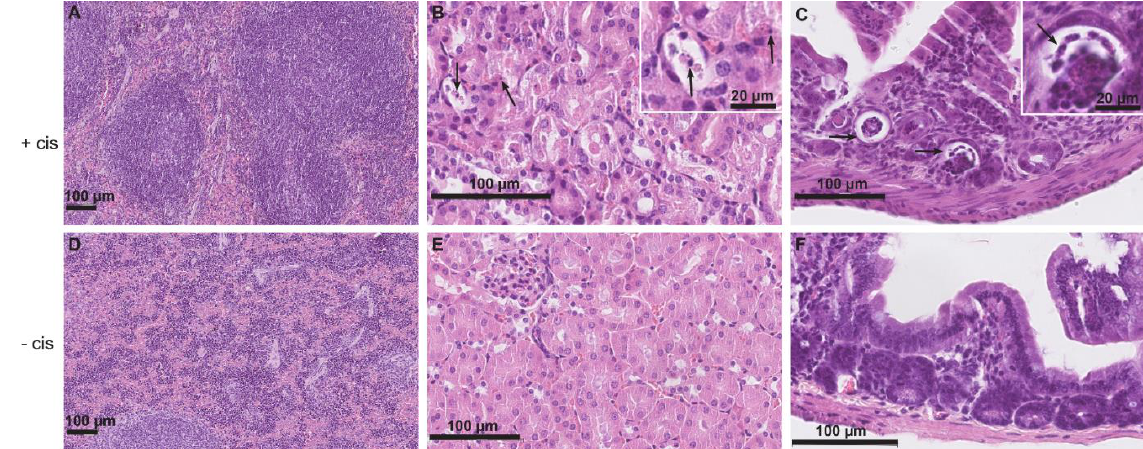
Figure 1. Representative micrographs of histopathologic changes of the spleen, kidney, and intestine in cisplatin-treated mice receiving MSCs labeled with NPs (+cis) ( A – C ) compared to control mice receiving MSCs labeled with NPs without cisplatin treatment ( − cis) ( D – F ). ( A ) In the spleen, cisplatin-induced widening of the red pulp and blurring of the boundaries between white and red pulp is evident. ( B ) In the renal cortex, numerous apoptotic tubular epithelial cells (arrows) are found. In the upper right corner is an insert with apoptotic epithelial cells at higher magnification. ( C ) In the intestine, necrotic epithelial cells are present particularly in crypts (arrows). In the upper right corner is an insert with necrotic epithelial cells at higher magnification. ( D – F ) Normal parenchyma of the spleen, kidney, and intestine of control mice receiving MSCs labeled with NPs. Scale bars: 100 µ m and 20 µ m.